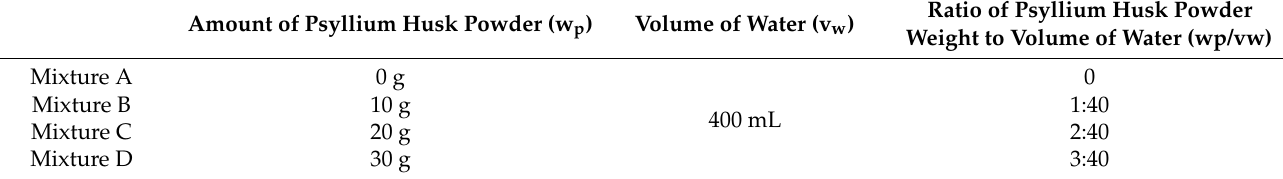
Table 1. Mixture compositions.